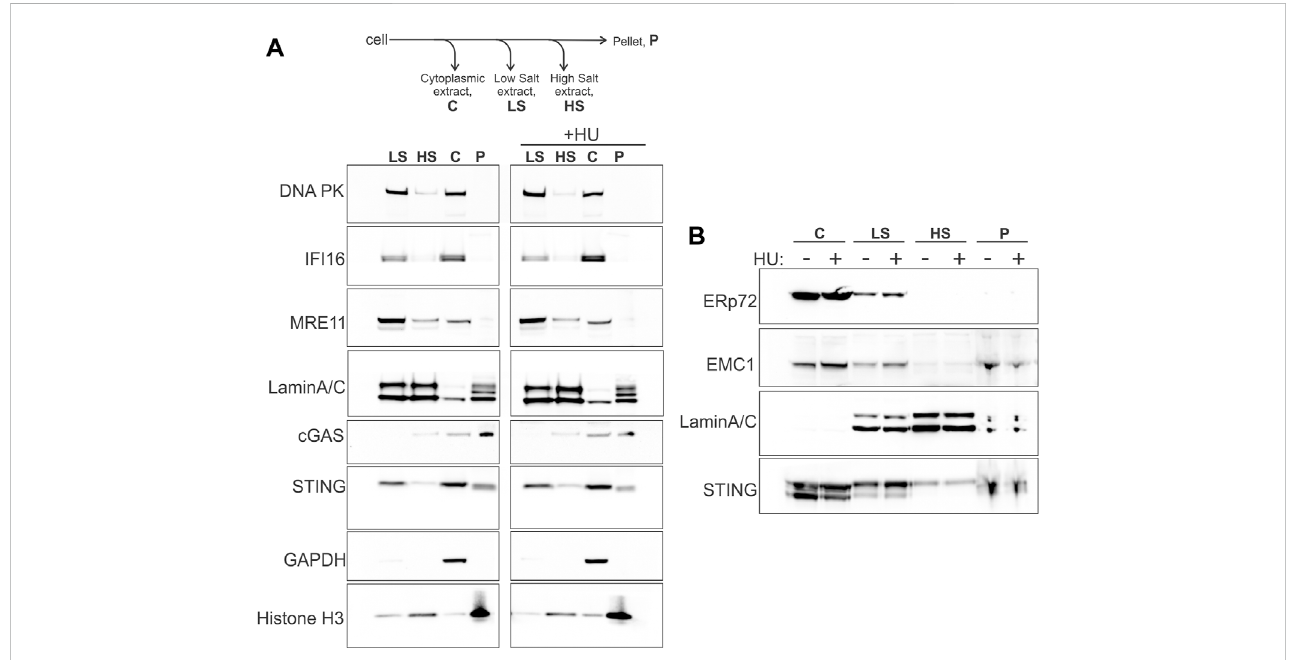
FIGURE 1 STINGfractionatesintonuclearandcytoplasmicfractions. (A) AfractionationschemeandWesternblotsprobedfortheindicatedproteinsinthefractions derived from the untreated (left panel) and HU-treated (right panel) WI38 hTERT fi broblasts. HU treatment was with 5 mM HU for 5.5 h. (B) The same samples as in (A) were re-run and probed for the proteins ERp72, EMC1, Lamin A/C, and STING. The loaded amounts of chromatin pellet were increased two-fold compared to (A) . A secondary band in the STING blot is STING degradation product. Here and elsewhere Western blot images are boxed to indicate the panels that were independently adjusted for brightness or come from separate protein